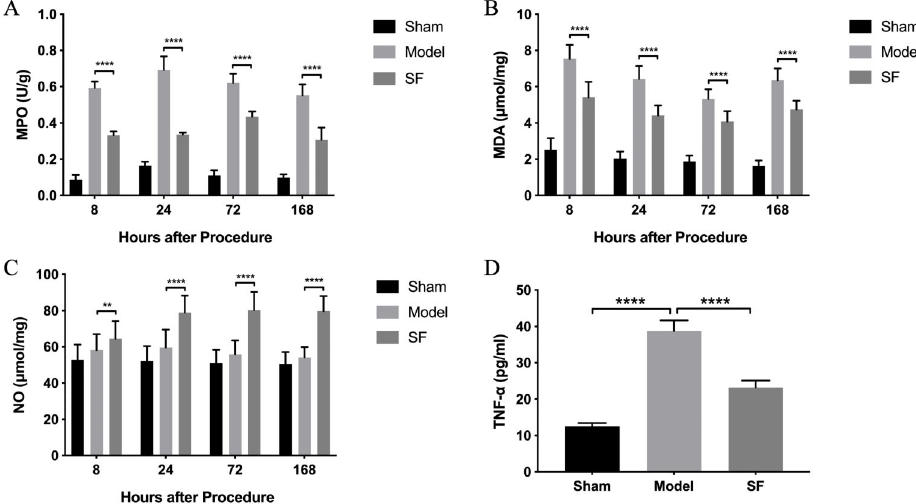
Figure 4. Myeloperoxidase (MPO), malondialdehyde (MDA), and nitric oxide (NO) changes in fl ap tissue. Tumor necrosis factor (TNF)- a levels in peripheral blood of sham surgery group, model group with experimental ischemia-reperfusion injury, and sodium ferulate (SF) treatment group (mean ± SD, n=6). **P o 0.05, ****P o 0.001, Student ’ s t